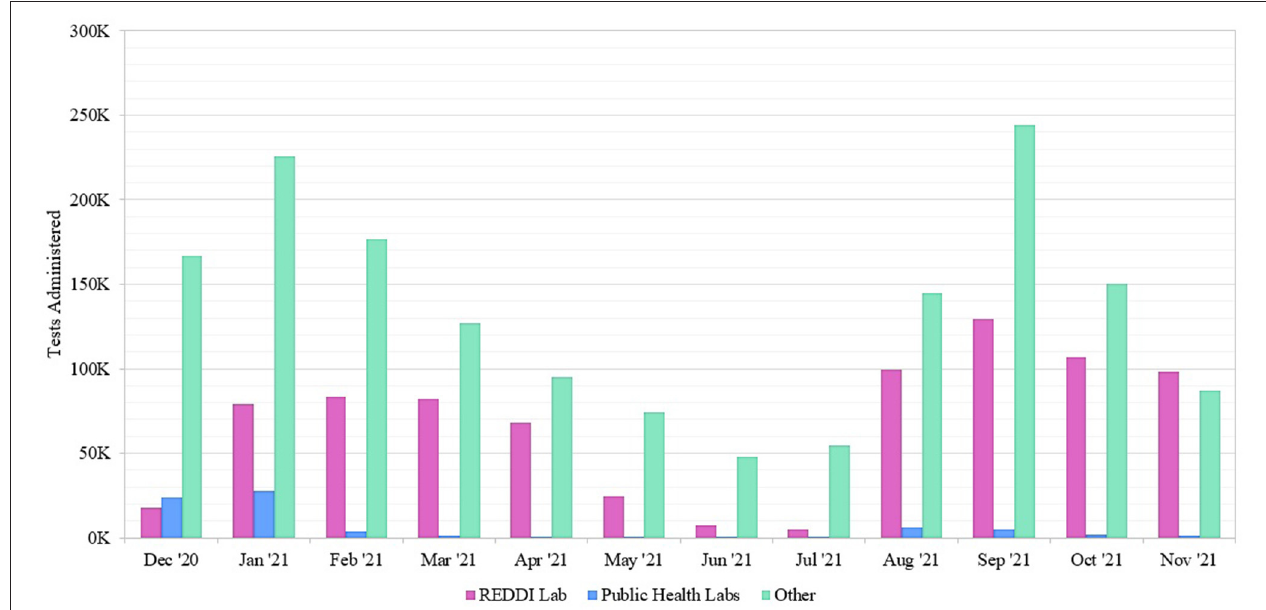
FIGURE 2 | Number of SARS-CoV-2 molecular tests performed at Upstate South Carolina testing sites offered by SCDHEC, REDDI Lab, and other labs from December 1, 2020–November 30, 2021. The REDDI Lab group includes all community and non-community molecular tests performed by the REDDI Lab.